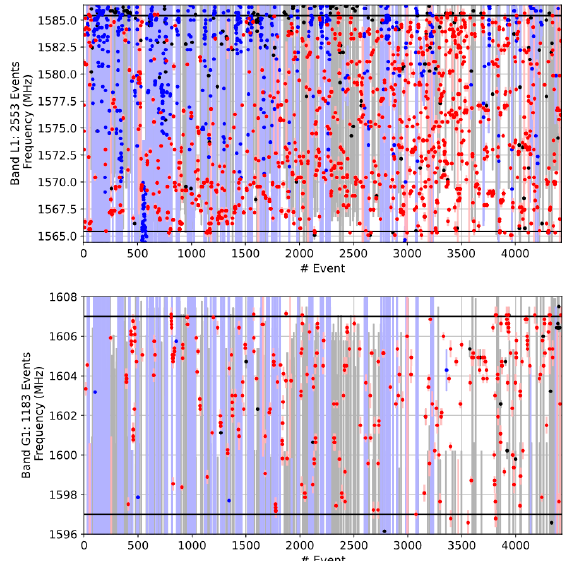
Figure 8. Band occupancy, Moss station, Norway, January-March 2022. Events that occur at the same time at different bands are given the same event number. The center frequency of each event is marked with a dot and the bandwidth with a vertical line. Narrowband events are indicated with red, wideband black and time-modulated blue. Black horizontal lines indicate the band limits.